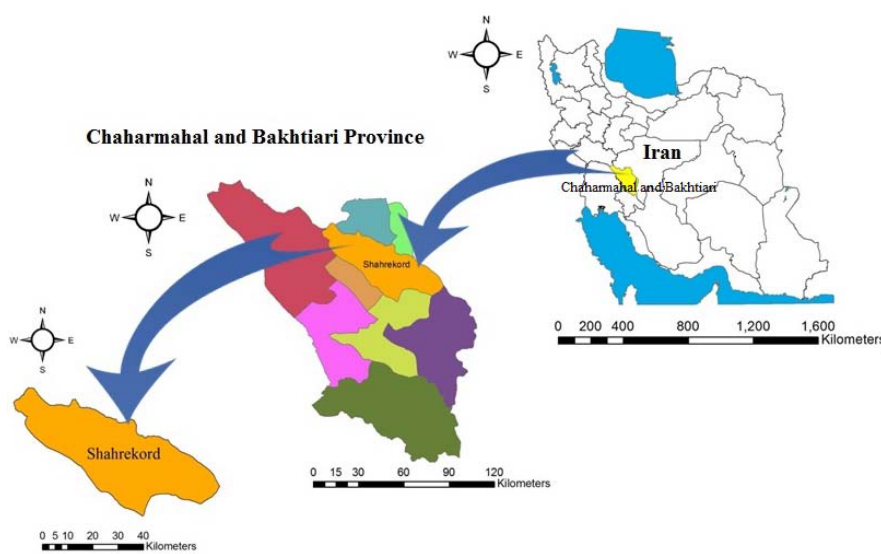
Fig. 1: The study Fig. 1: The study area